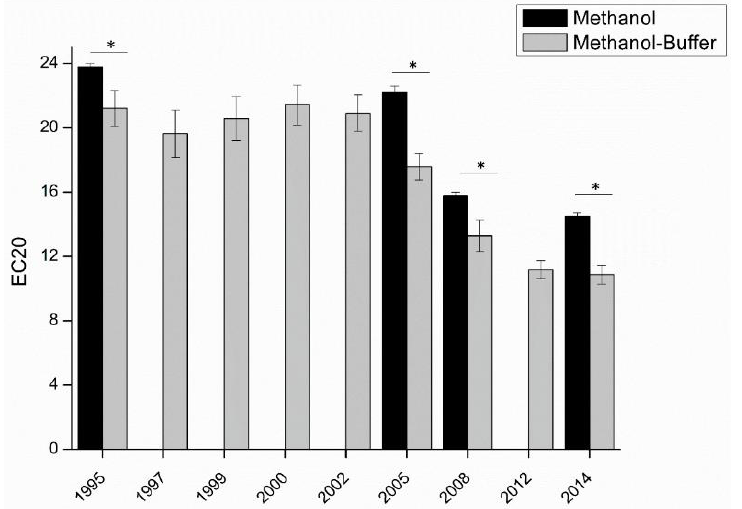
Figure 6. Comparison of the antioxidant capacity of the same appellation from nine vintages from the same winery. Measurements in methanol (black), and in methanol-buffer (grey). Student tests show comparison between methanol and methanol-buffer methods, “*” indicate significant differ- ence ( p < 0.05).[26].